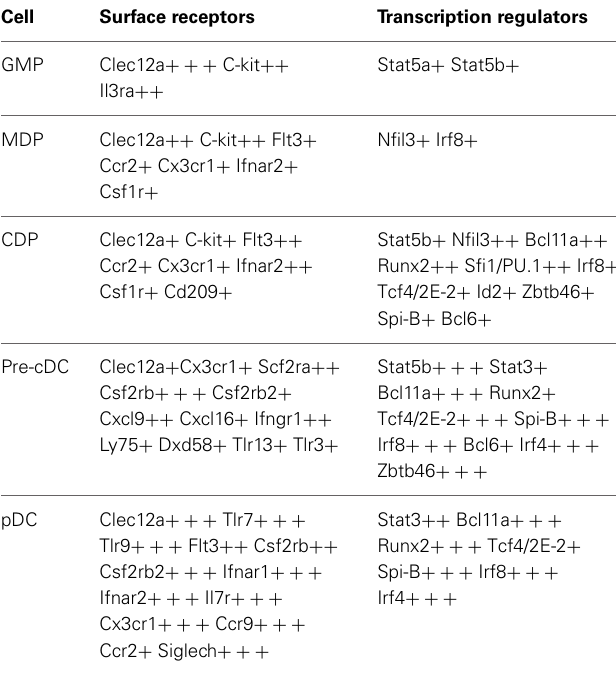
Table 1 | Expression of transcription regulators and receptors essential for differentiation of mouse DCs and their progenitors